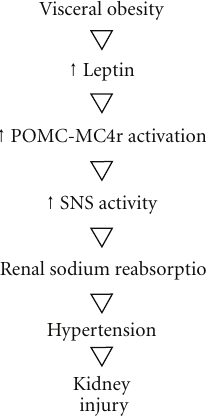
Figure 1: Leptin and SNS activity.